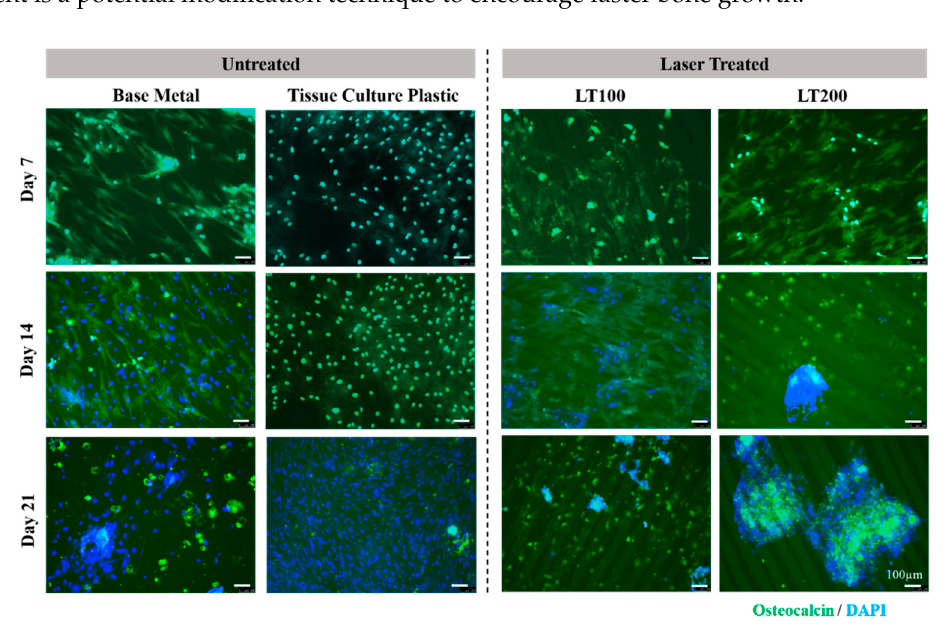
Figure 7. Laser surface treatment encourages formation of bone-like nodules, indicating potential faster osseointegration. Merged fluorescence images of MSCs stained at Day 7, 14 and 21 at 100× magnification on untreated and laser treated surfaces. Green = osteocalcin protein; blue = DAPI nuclei stain. Scale bar = 100 µm. Images are representative of cell coverage on the entire surface.